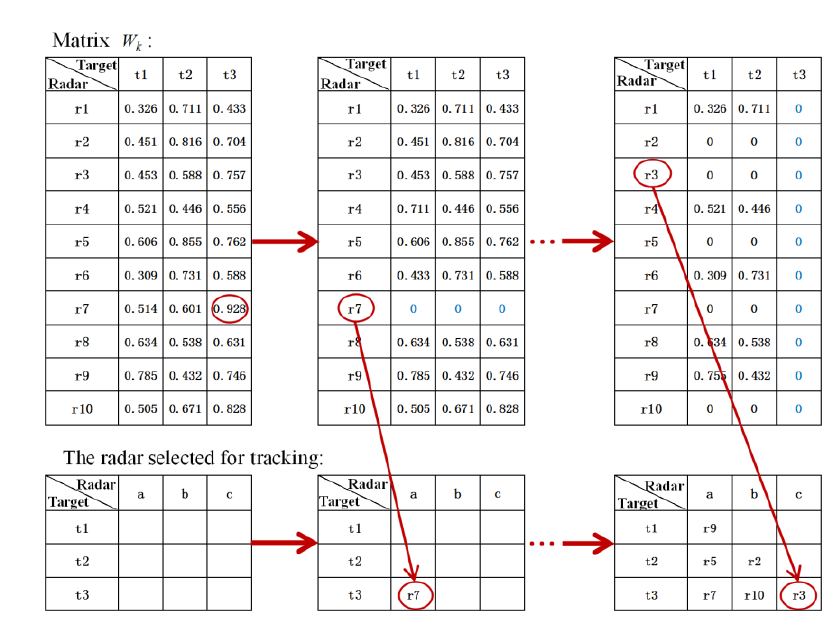
Figure 5. Example of radar assignment process.